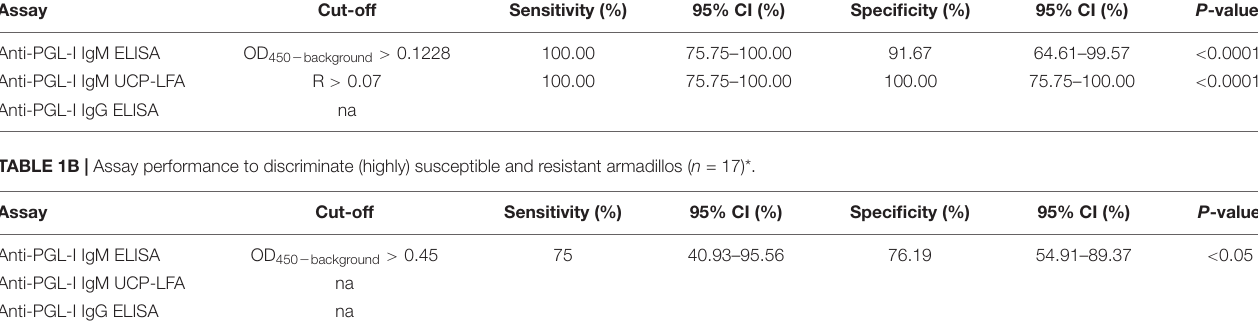
TABLE 1A* | Assay performance to discriminate pre- and post-infection ( n = 12)*. Assay Cut-off